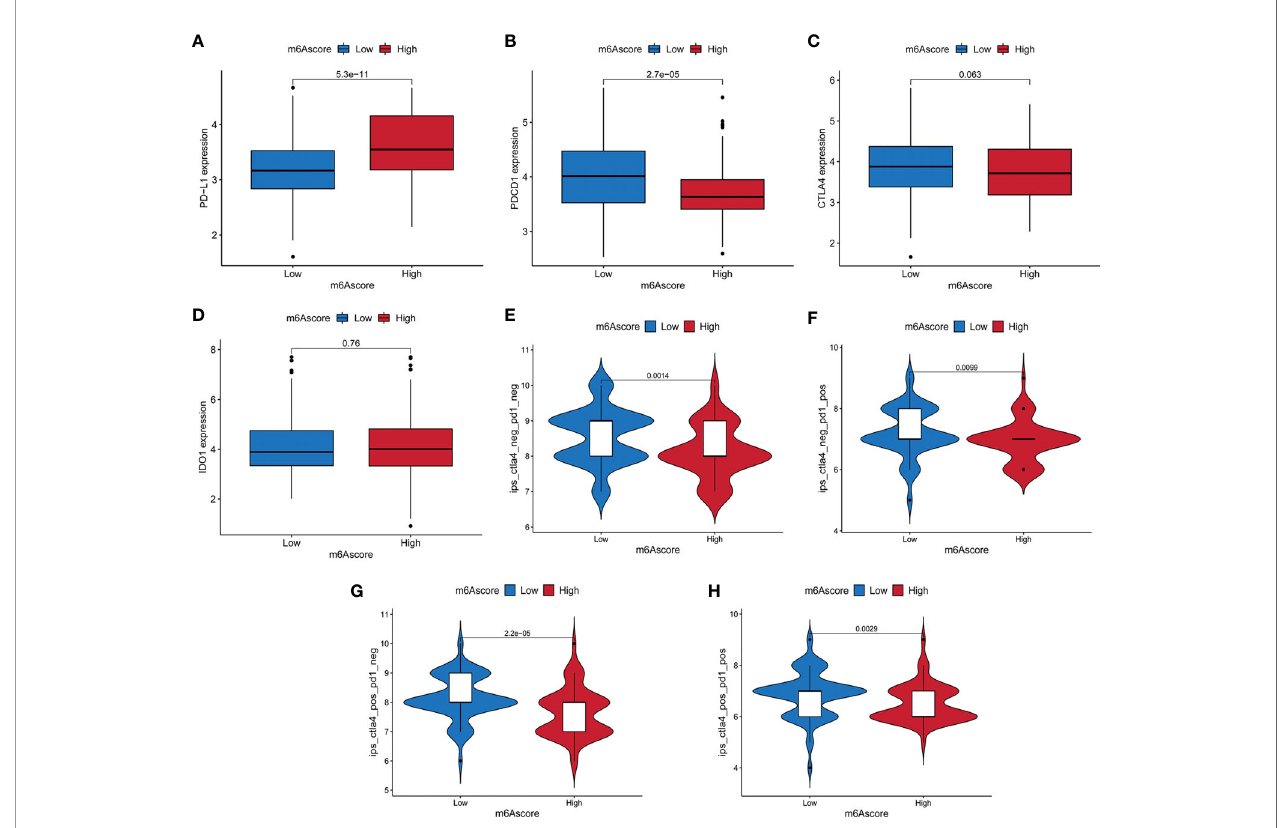
FIGURE 7 | The relationship between m 6 A score and immune checkpoint genes and immunotherapy. (A – D) The expression differences of PD-L1, PDCD1, CTLA4 and IDO1 between high and low m 6 A score groups. (E) The difference of Immunophenoscore (IPS) between high and low m 6 A score groups with CTLA4 (-)/PD1 (-). (F) The difference of IPS between high and low m 6 A score groups with CTLA4 (-)/PD1 (+). (G) The difference of IPS between high and low m 6 A score groups with CTLA4 (+)/PD1 (-). (H) The difference of IPS between high and low m 6 A score groups with CTLA4 (+)/PD1